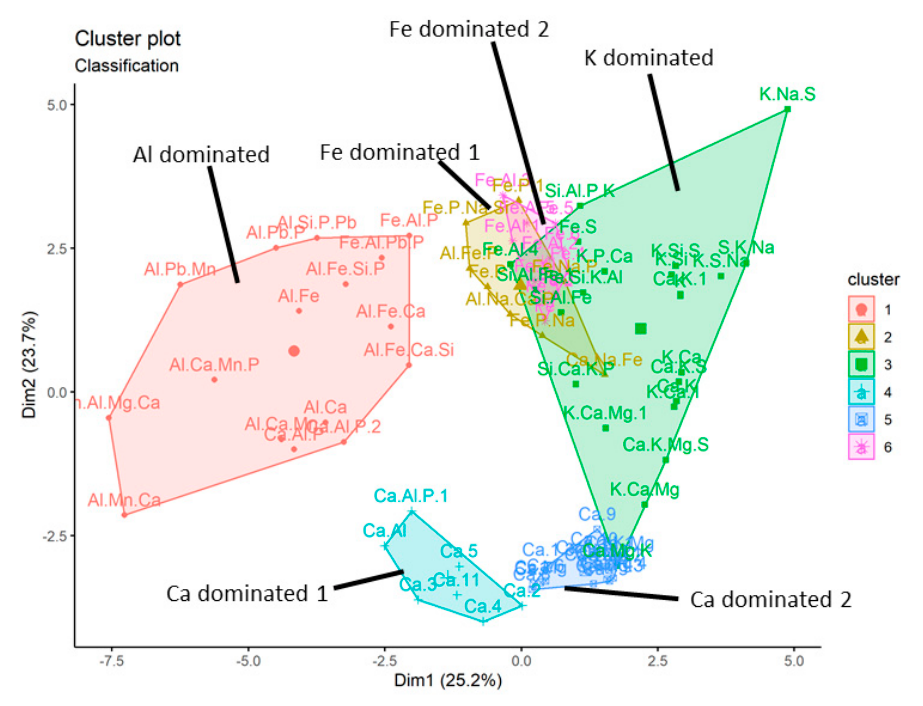
Figure 3. Cluster groupings for the geochemical components found in the